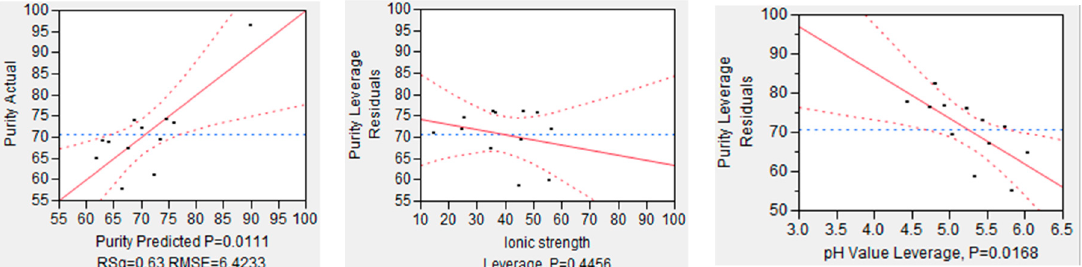
Figure 11. Statistical analysis of the DoE results regarding mAb purity. (Left) prediction model of mAb purity is shown. (Middle) leverage effect analysis of purity regarding ionic strength. (Right) leverage effect analysis of purity regarding pH value.